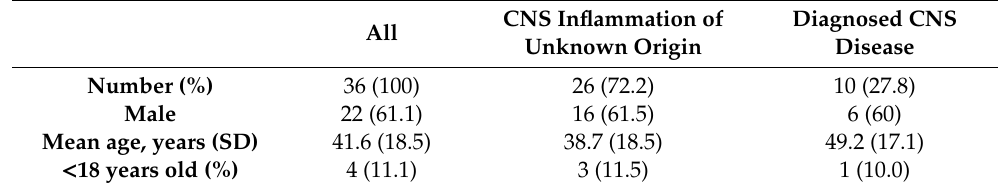
Table 2. Demographic characteristics of patients with central nervous system (CNS) disease.